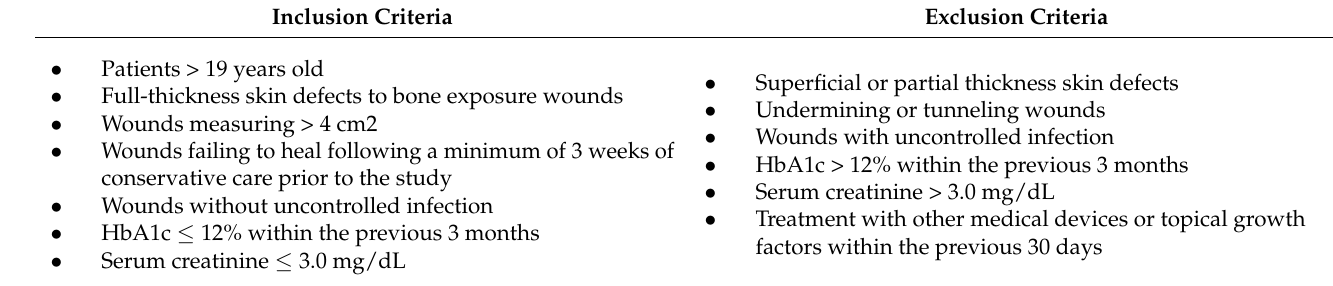
Table 1. Inclusion and exclusion